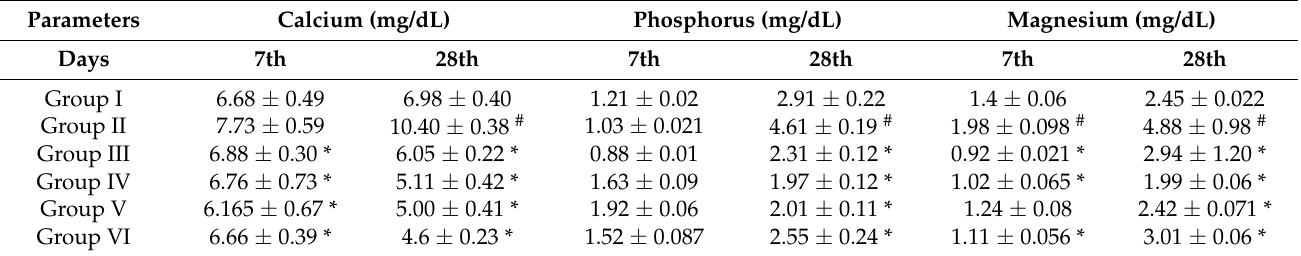
Table 2. Effect of therapeutic interventions on urinary calcium, magnesium, and phosphorus levels.